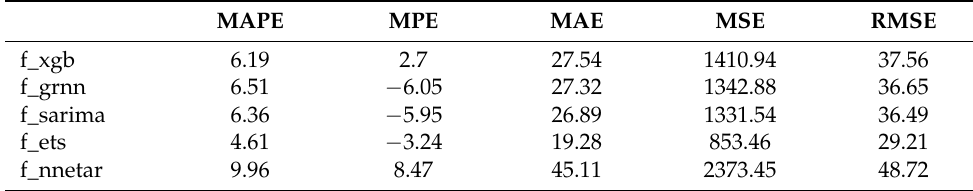
Table A1. Quaterly forecast error measure.